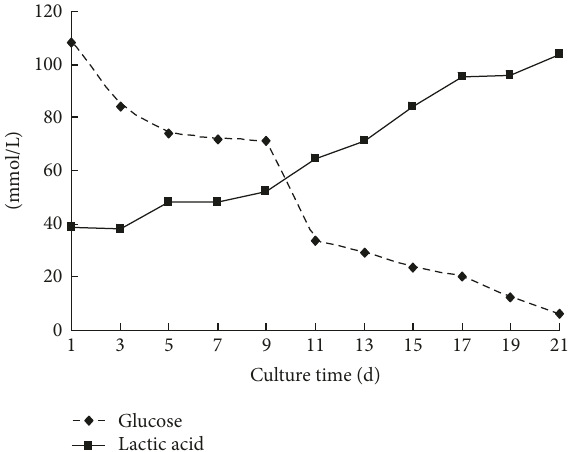
Figure 3: Concentration-time curve of glucose and lactic acid detected in the supernatant of microencapsulated SGC9701 cells.